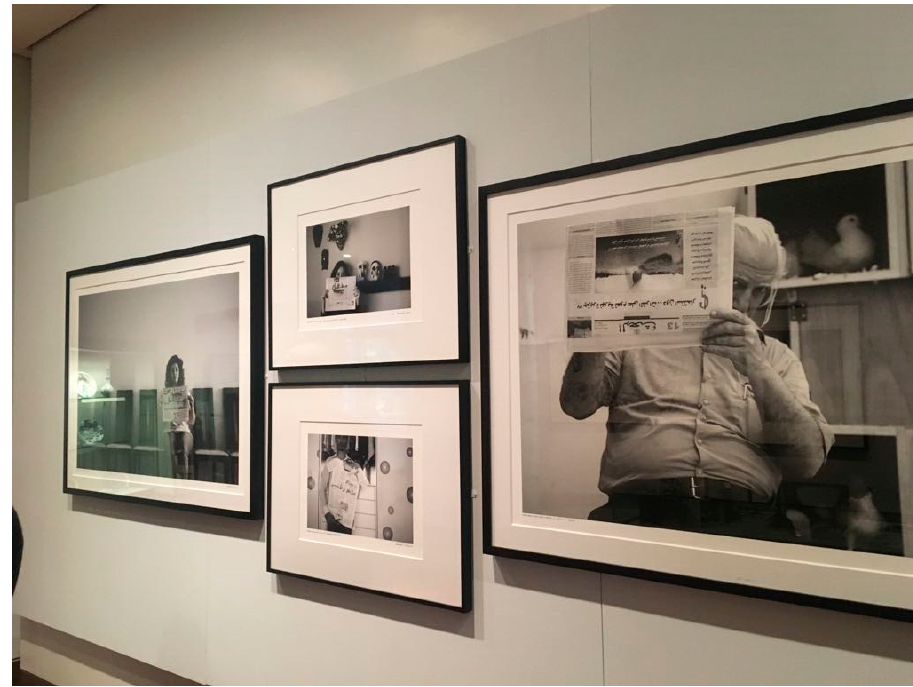
Figure 4. Detail from ‘The Resurrection’ (2014) by Jaber. (Printed on Cotton Rag Fine Art Archival paper.) London, UK: British Museum. Photograph by the author.